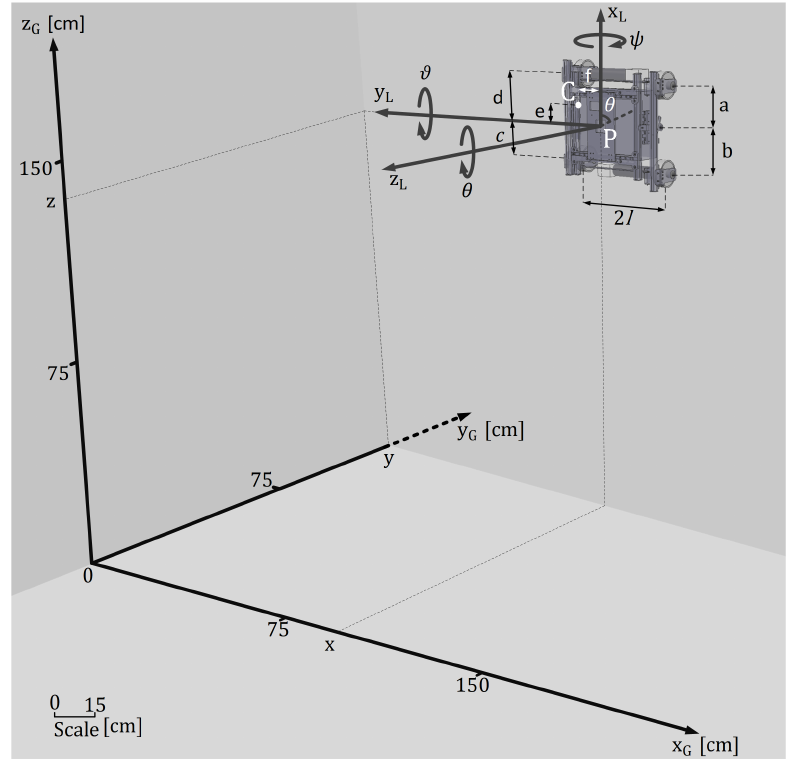
Figure 3. Coordinate frames in differential four-wheeled climbing